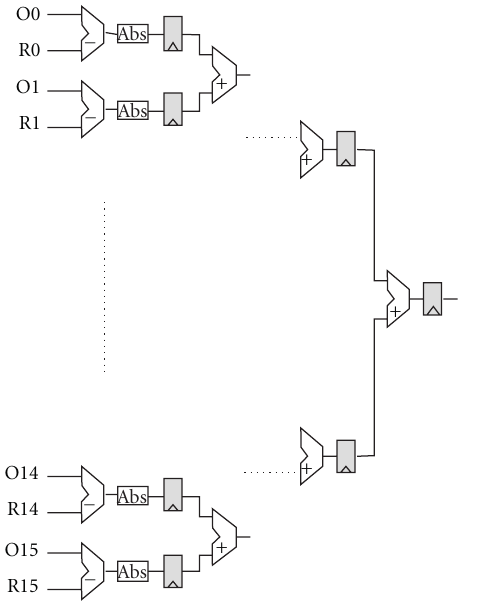
Figure 9: PU architecture.